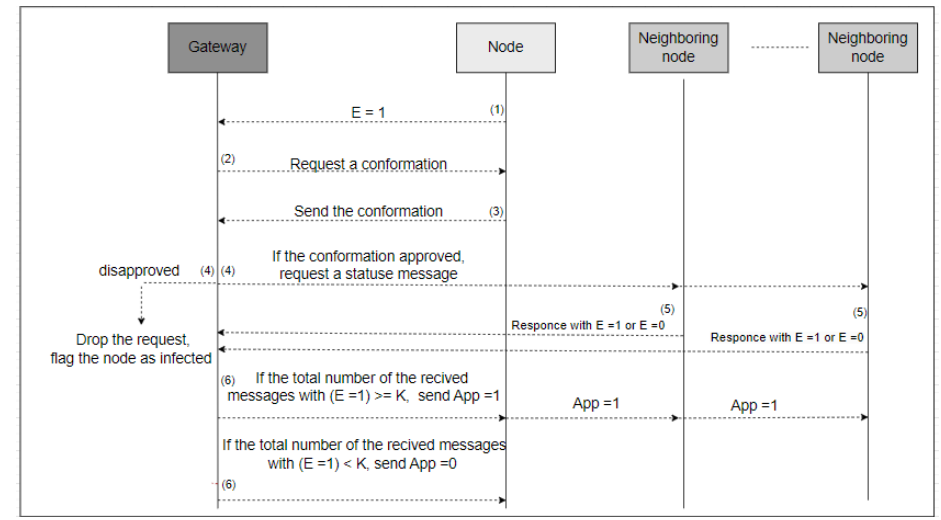
Figure 1. The network architecture steps. Table 2. Notations of the proposed